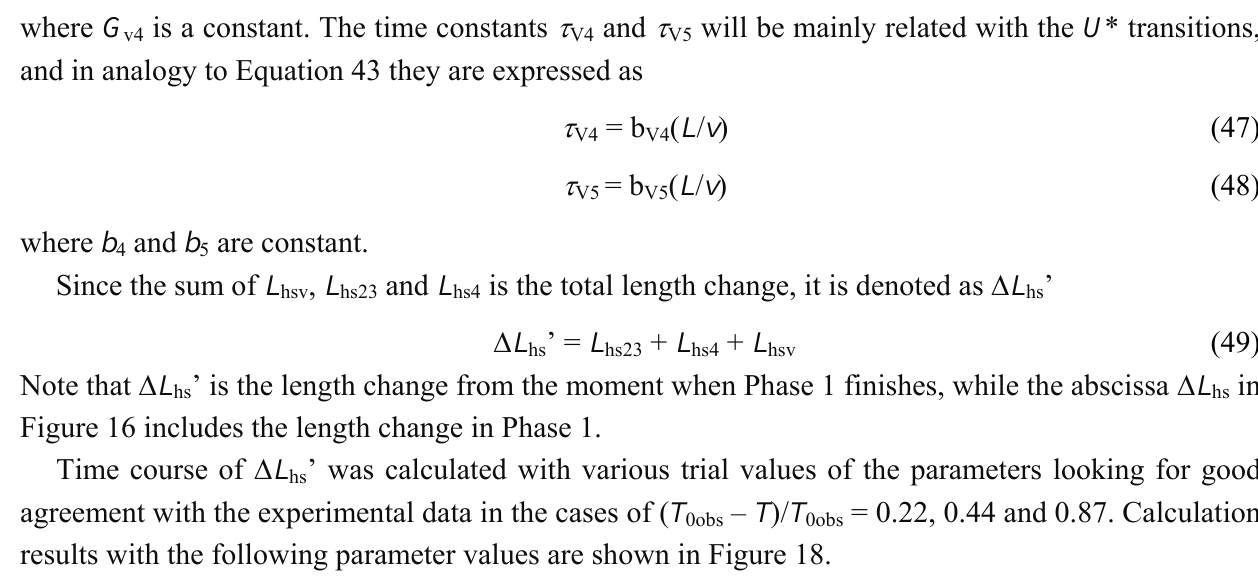
Figure 18. Length change  L